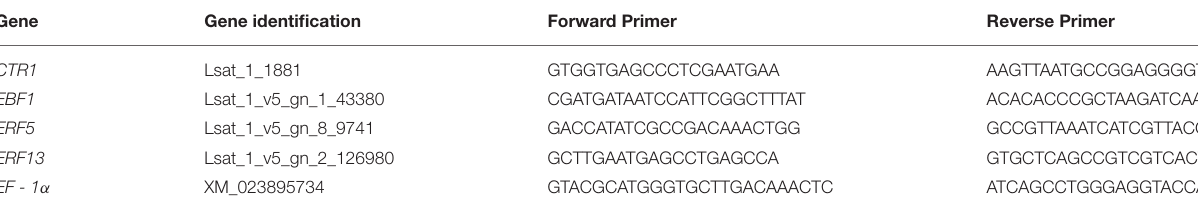
TABLE 2 | Identification of L. sativa gene homologs related with ethylene signaling, and primers used in qPCR experiments. Gene